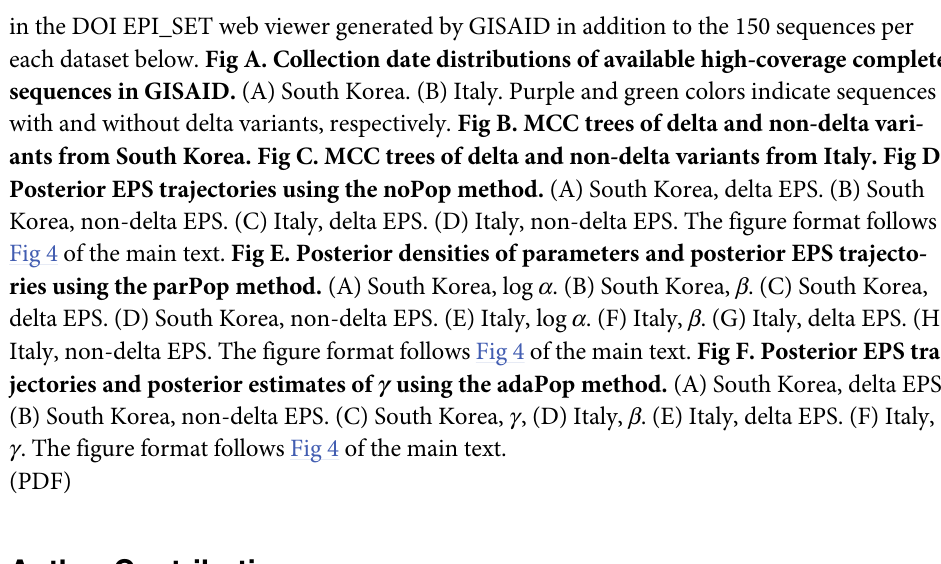
Fig 4 of the main text. Fig E. Posterior densities of parameters and posterior EPS trajecto- ries using the parPop method. (A) South Korea, log α . (B) South Korea, β . (C) South Korea, delta EPS. (D) South Korea, non-delta EPS. (E) Italy, log α . (F) Italy, β . (G) Italy, delta EPS. (H) Italy, non-delta EPS. The figure format follows Fig 4 of the main text. Fig F. Posterior EPS tra- jectories and posterior estimates of γ using the adaPop method. (A) South Korea, delta EPS. (B) South Korea, non-delta EPS. (C) South Korea, γ , (D) Italy, β . (E) Italy, delta EPS. (F) Italy, γ . The figure format follows Fig 4 of the main text.